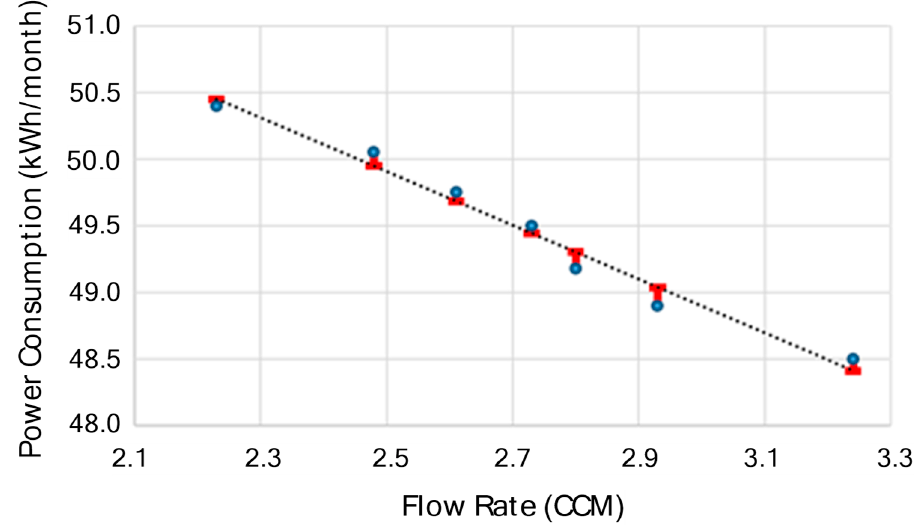
Figure 12. Power consumption for various flow rates of the cooling fan.